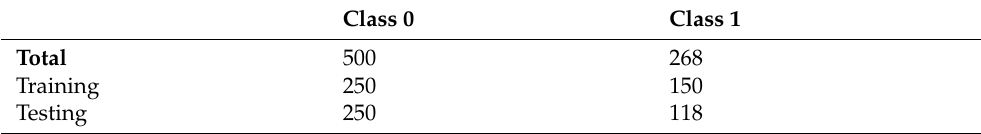
Table 4. Dataset division into training and testing. Class 0 Class 1 Total 500 268 Training 250 150 Testing 250